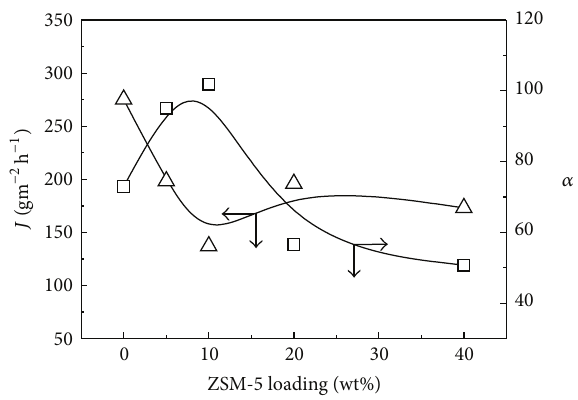
Figure 4: Tensile strength and Young’s modulus of PEBA/ZSM-5 membranes with different ZSM-5 loading.